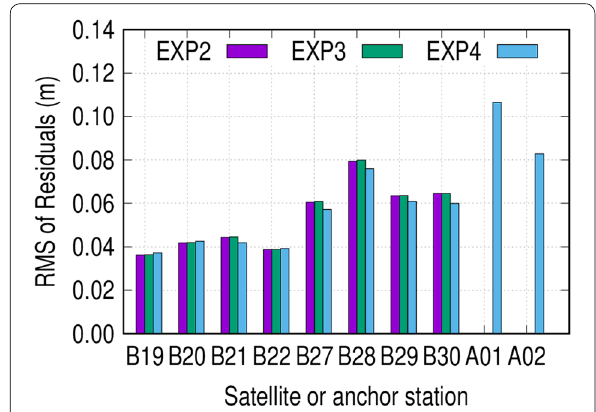
Fig. 5 The RMS of residuals of one-way Ka-pseudoranges observed at each satellite or anchor station in EXP2, EXP3, and